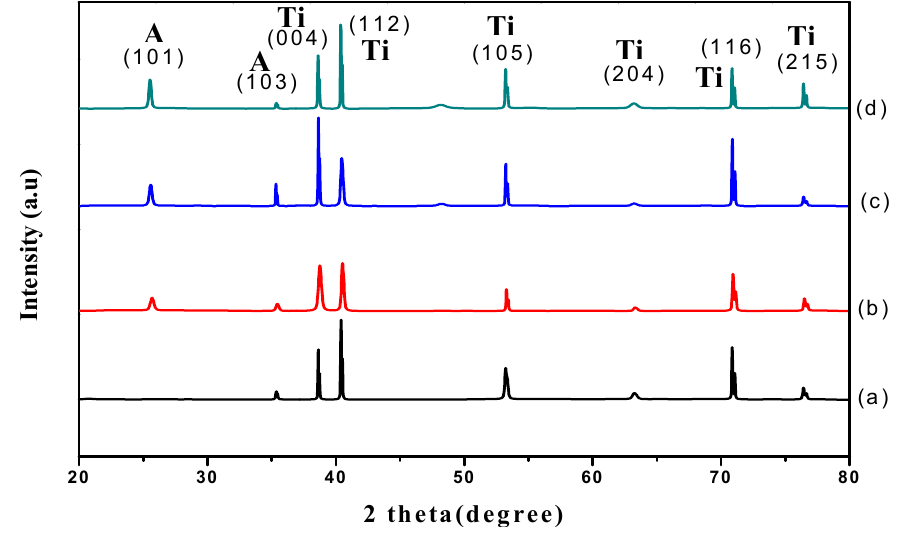
Figure 4. XRD patterns of TiO 2 grown at 30 V and annealed at 450 °C for 2 h with anodizing time of ( a ) 30 s; ( b ) 10 min; ( c ) 20 min and ( d ) 60 min.